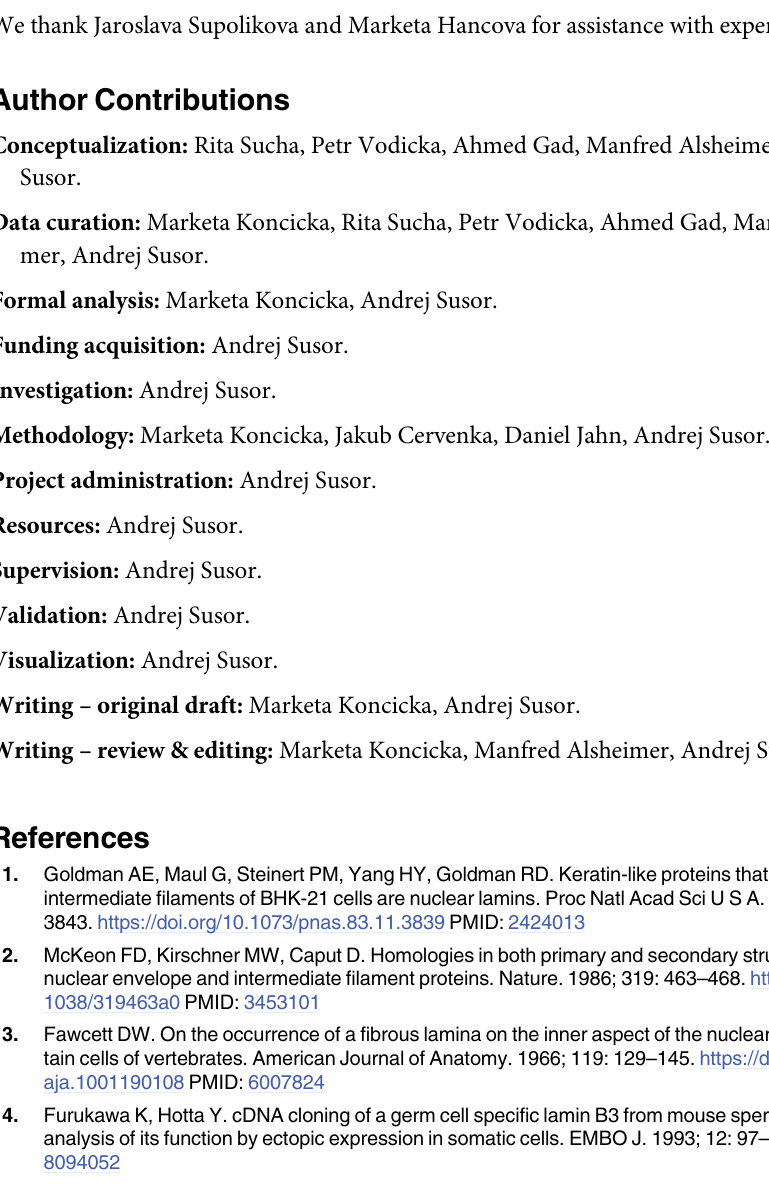
S2 Fig. Full immunoblots and PCR gels of segments shown in the main Figs 1 and 4A. Rect- angle denote the bands presented. S3 Fig. Full immunoblots and PCR gels of segments shown in the main Figs 4B, 5, 6 and S1. Rectangle denote the bands